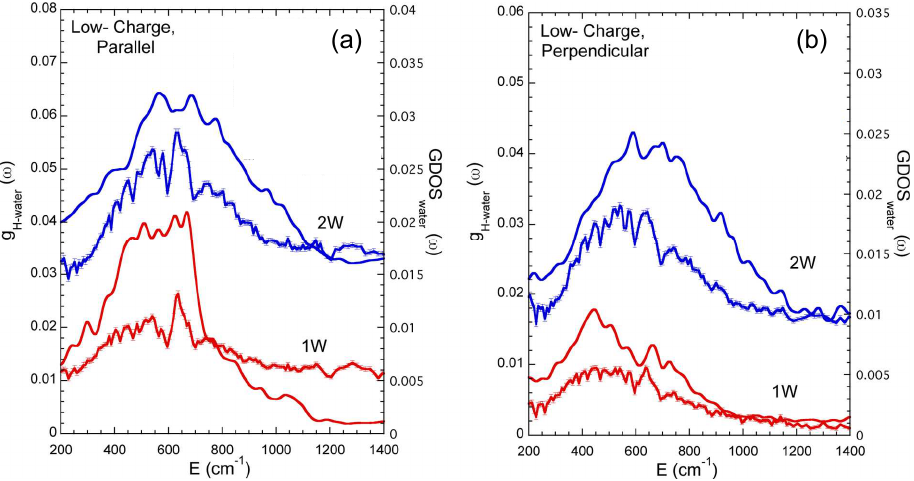
Figure 3. Comparison between the experimental GDOS water ( ω ) and simulated g H − water ( ω ) , see Equation (2), for INS spectra of hydrated saponite sediments along the directions parallel ( a ) and perpendicular ( b ) to the clay layers (see text). Reprinted with permission from Ref. [18]. Copyright (2017) American Chemical